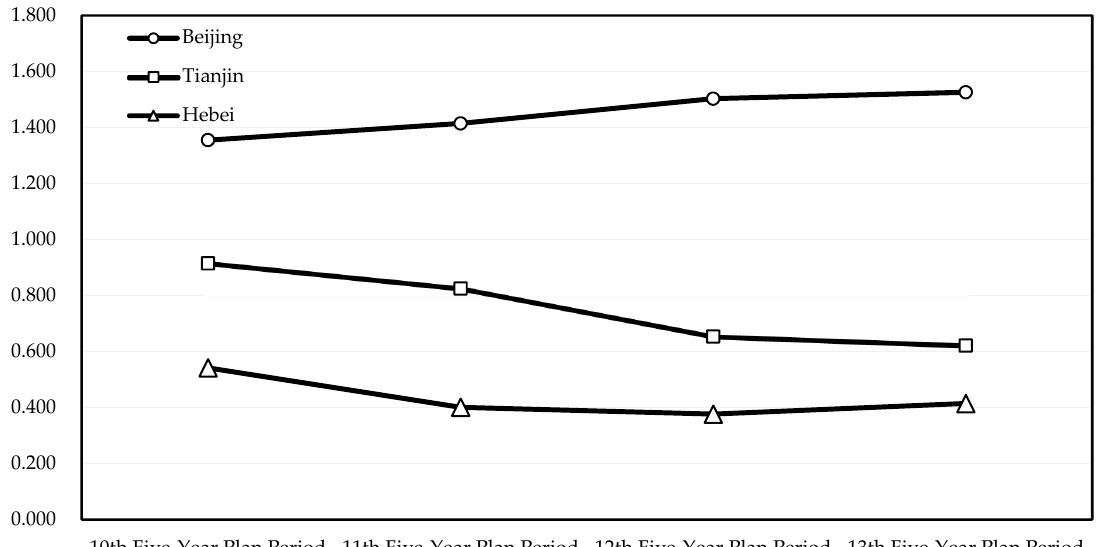
Figure 3. Changes in the mean value of efficiency in Beijing, Tianjin and Hebei in different periods. Table 4. Change in the mean value of efficiency between periods.